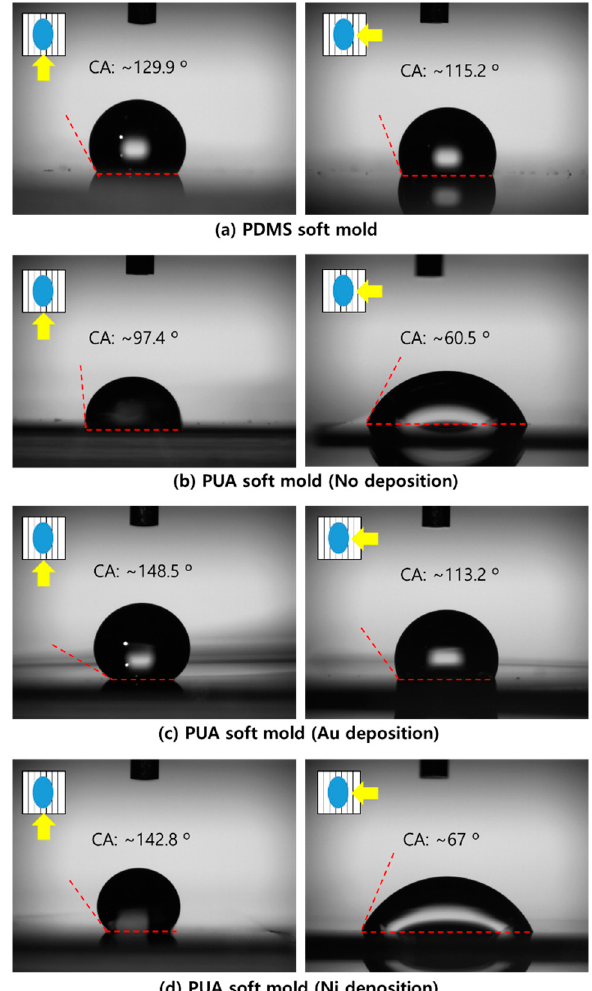
Figure 3. Contact angles of parallel ( θ (cid:107) ) and perpendicular ( θ ⊥ ) to the nanoline for various soft molds. From the movement of liquid along the nanoline pattern in Figure 3, the contact angles can be considered to have been measured in Wenzel state [22–27]. To derive the accurate surface energy of the soft molds, a process of calibrating the contact angle measured